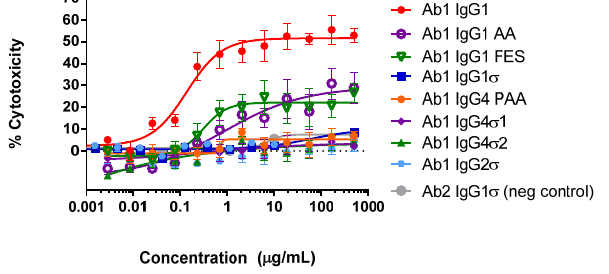
Figure 6. Cell ‐ based CDC assays with IgG Fc variants. K2 mouse myeloma cells stably expressing a transmembrane form of human tumor necrosis factor alpha (TNF α ) were incubated with varying concentrations of test antibody and rabbit complement, and then cell viability was measured by detecting lactate dehydrogenase release in the culture supernatant. Error bars represent standard error of the mean from samples analyzed in triplicate. Ab2 IgG1 σ does not bind to target cells and is the negative control antibody.